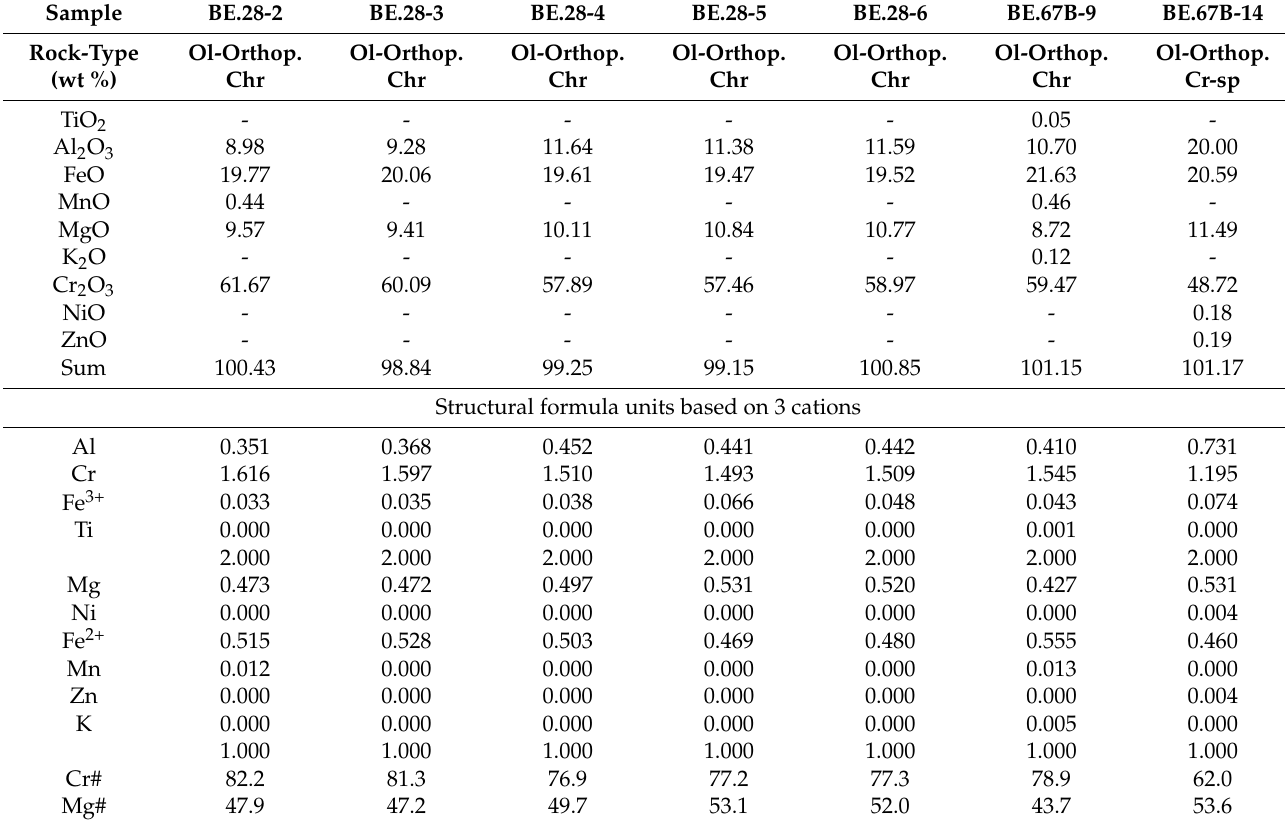
Table 4. Representative electron microanalyses of spinel-group minerals from the Veria-Naousa Ol-orthopyroxenite (-: below detection